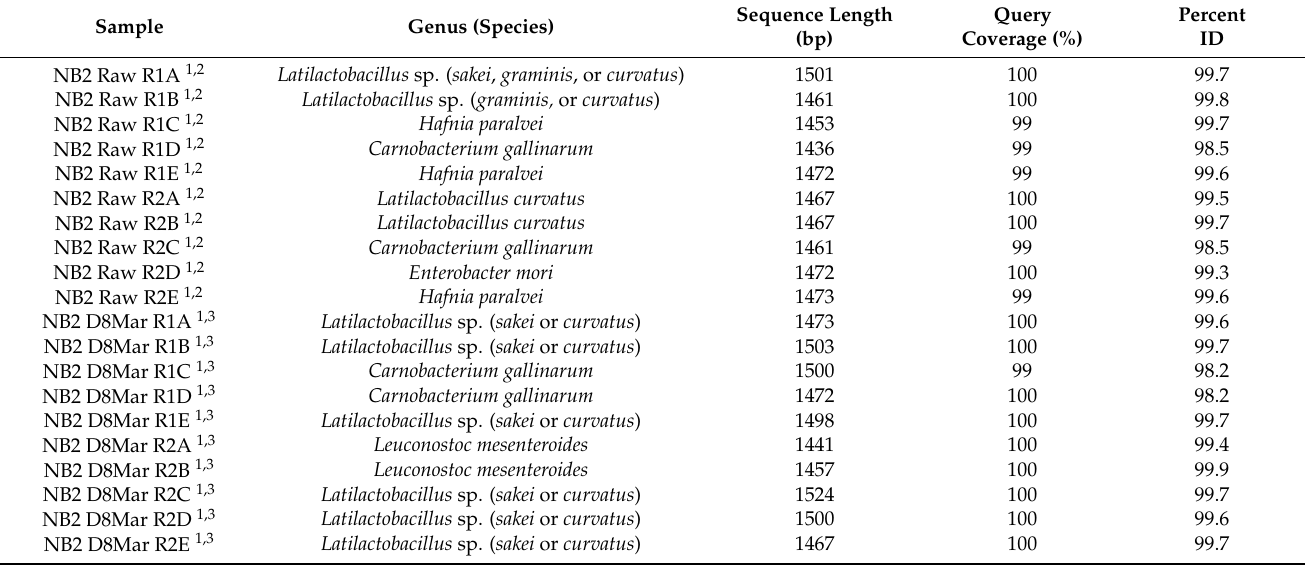
Table 2. Bacterial isolates identified from Nebraska Beef (NB2) based on 16S rRNA gene sequencing analysis of isolates obtained from raw beef (Raw) and marinaded beef after 8 days of drying (D8) for trial 1 (R1) and trial 2 (R2).